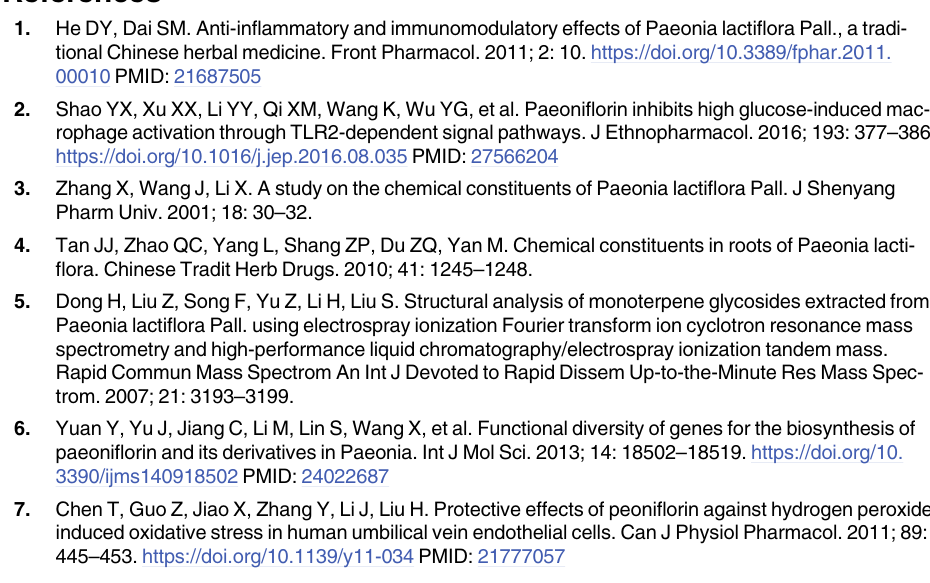
S5 Fig. Conservation Profile of the identified miRNAs. (TIF) S6 Fig. T-plots for miRNA targets in the 5 diverse catagories verified by degradome